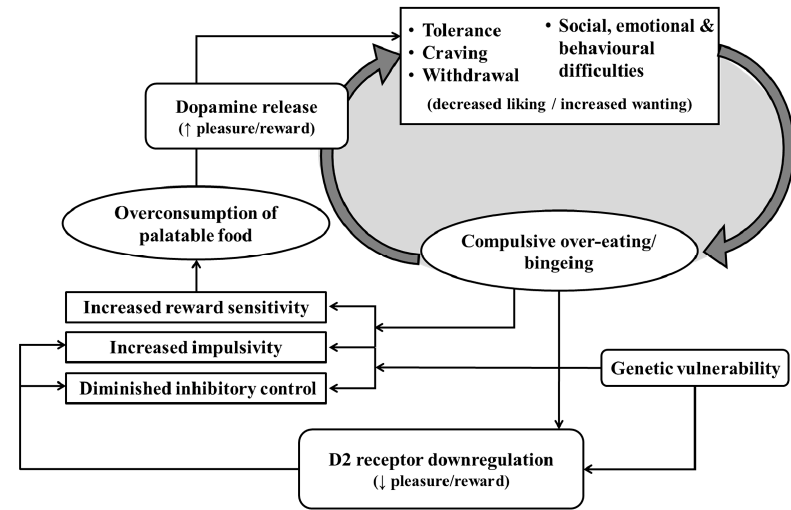
Figure 2. The proposed cycle of ‘food addiction’ including the role of dopamine. When palatable food is consumed, the brain releases the hormone dopamine (alongside other neurotransmitters such as opioids). Over time, this increase in dopamine leads to the downregulation of dopamine receptors, causing individuals to experience a reduction in pleasure during palatable food consumption. This